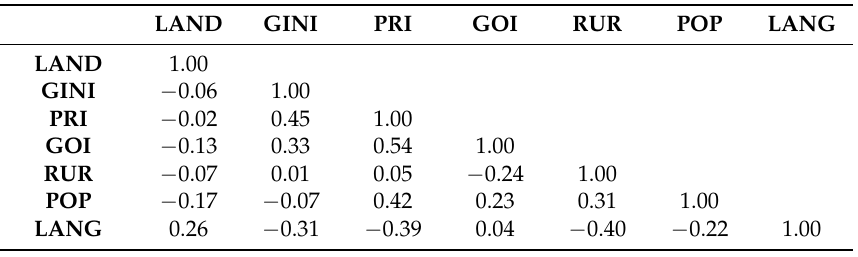
Table 6. Correlation among variables of the “security of investment” group.